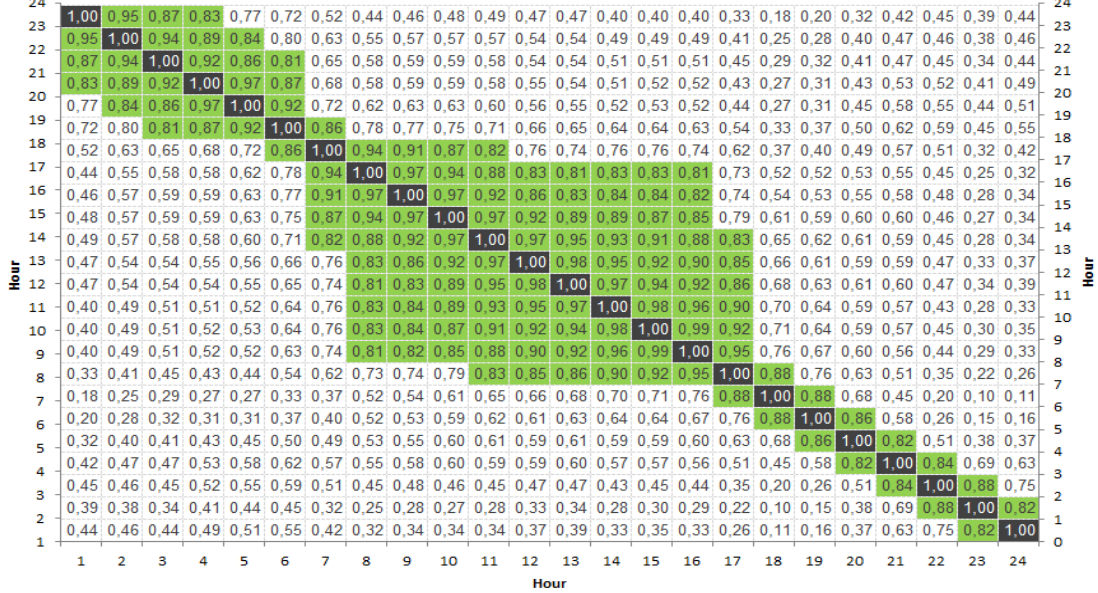
Figure 4. Correlation matrix of EEX hourly data averages for the period from 20 November 2010 to 20 July